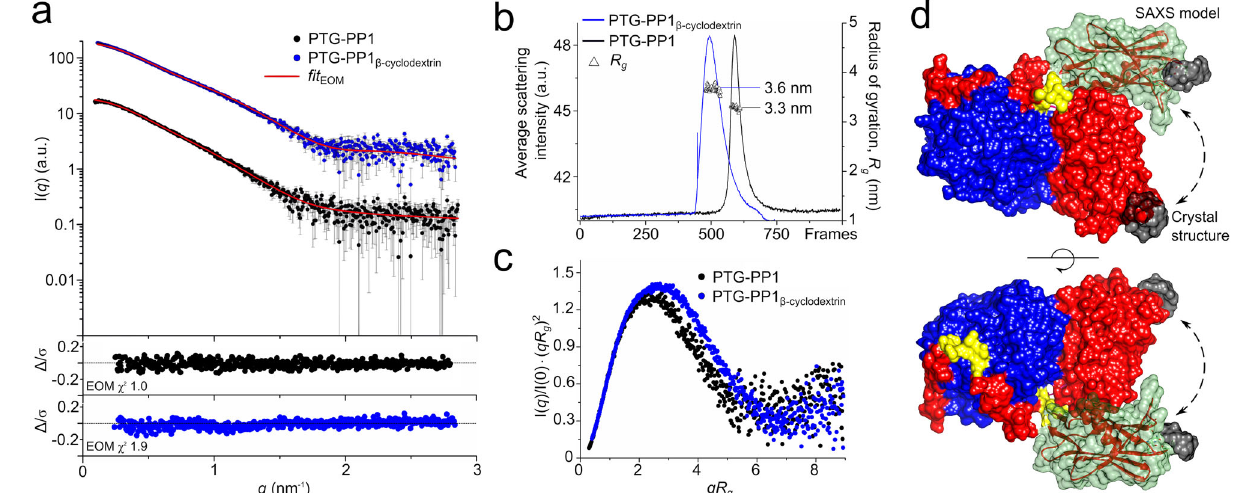
Fig.5|SAXSstudiesonthebinaryandternaryPTG-PP1complexes.a Shownare I ( q )versus q experimentalSAXSpro fi lesforapoPTG-PP1(blackdots)andboundto cyclodextrin (blue dots) with the EOM fi t (red lines). SAXS curves were obtained through averaging of buffer-background subtracted frames across the entire elu- tion traces of the SEC-SAXS experiments (approximately n =50 frames averaged, see Supplementary Table 4). Error bars represent an estimate of the experimental error, σ , on the intensity recorded for each value of q assigned by data reduction software 57,58 .Chi 2 values( χ 2 )fortheEOM fi ttingareindicated.Thecurvesareshifted by an arbitrary offset for better comparison. The lower plots show the error- weighted residual difference plots. b SEC-SAXS chromatograms of PTG-PP1 com- plexaloneandboundto β -cyclodextrin.Theblackandbluelinesrepresentthetotal summed scattering intensity for PTG-PP1 and PTG-PP1+ β -cyclodextrin,